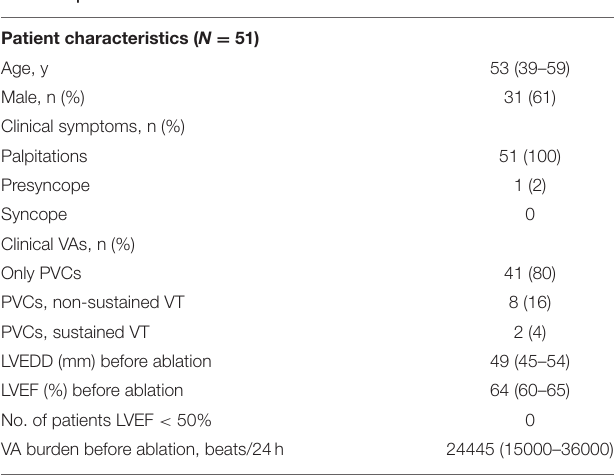
TABLE 1 | Baseline characteristics.